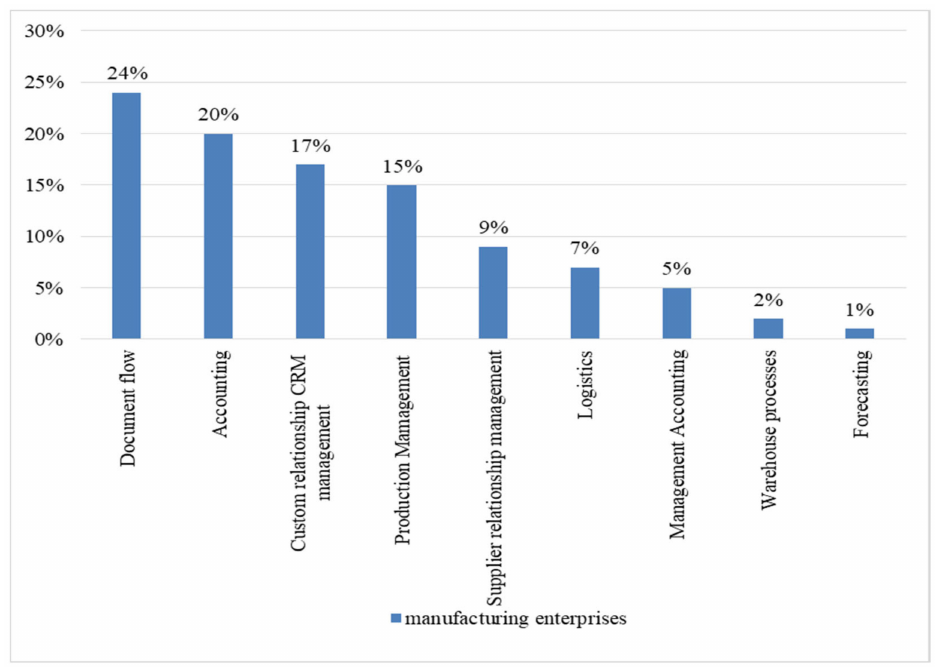
Figure 1. Basic automated business processes at manufacturing enterprises of the Republic of